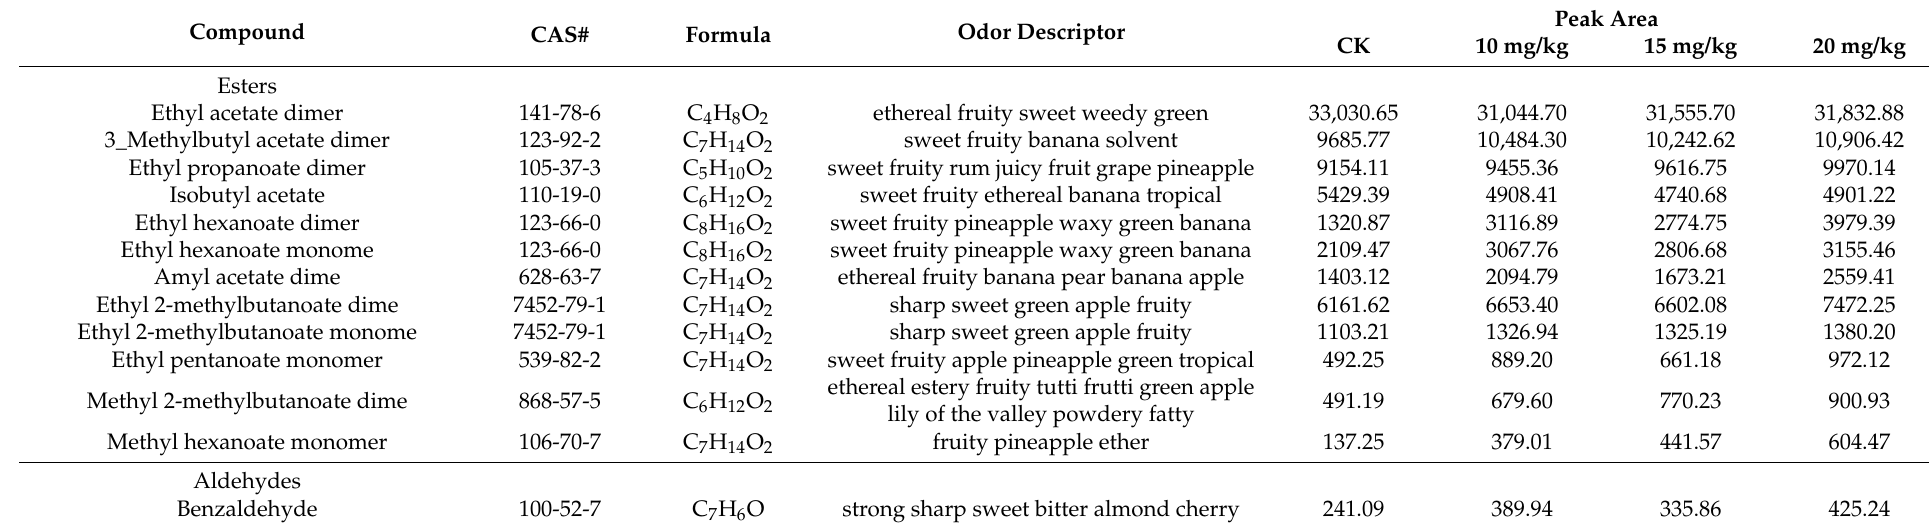
Table 2. The 13 difference markers of the volatile flavor compounds of oriental melon under different treatment